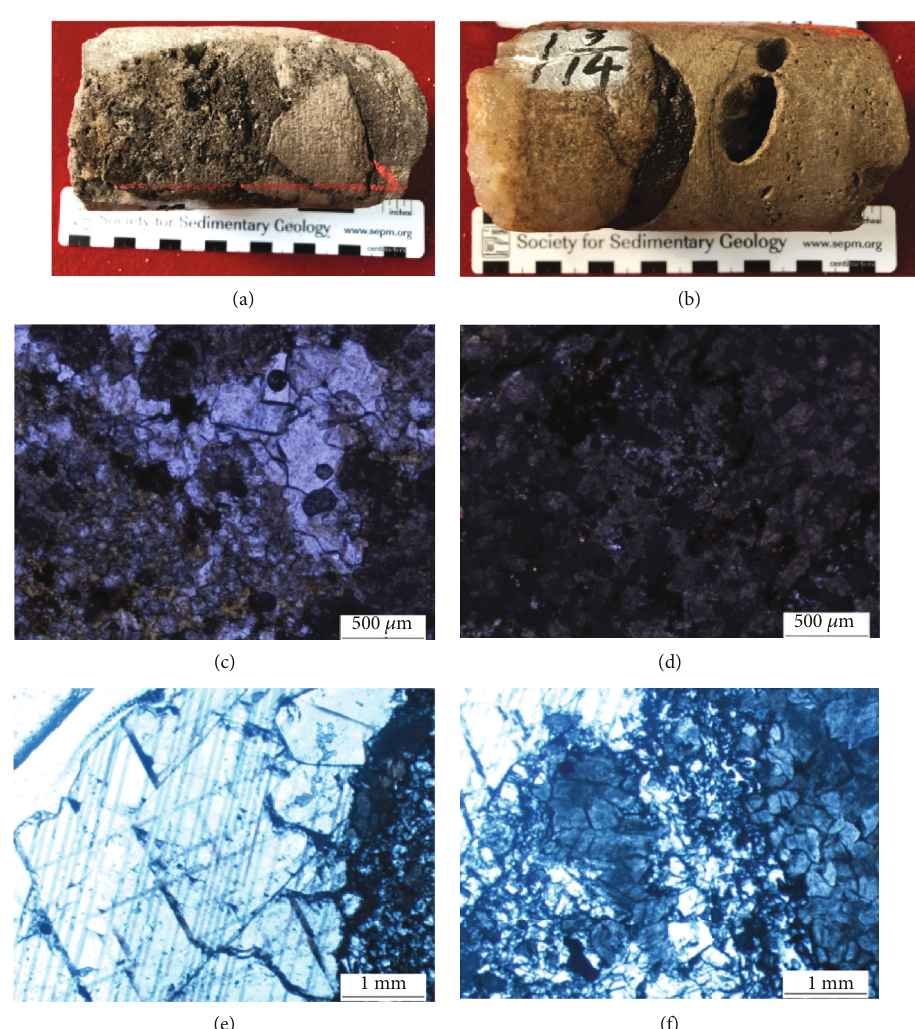
Figure 3: The upper unit characteristics of Well SHBP 1. Microscopic/petrographic characteristics of samples in the upper unit: (a) Gray siliceous dolomite. The dissolution of dolomite and matrix breccia can be found in the fracture, and the dissolution is fi lled with siliceous and calcite cement, 8453.72-8453.82m; (b) Fine-medium crystal dolomite. Corrosion pores, 20-50 mm in diameter, are fi lled with calcite and siliceous parts. There are directional distribution characteristics in the pores, and honeycomb dissolution can be found along the cracks, 8451.12-8451.24m; (c) Microscopic photo of (a) quartz grains in the intercrystallite of honeycomb dolomite develops the secondary calcite, 8453.74m, PPL; (d) Siliceous fi ne-monocrystalline dolomite. Suture Wire Cut Dolomite, 8452.14m, PPL; (e and f) Powder- fi ne dolomite. Honeycomb structure, edge of siliceous, and giant crystal calcite, 8450.02m,